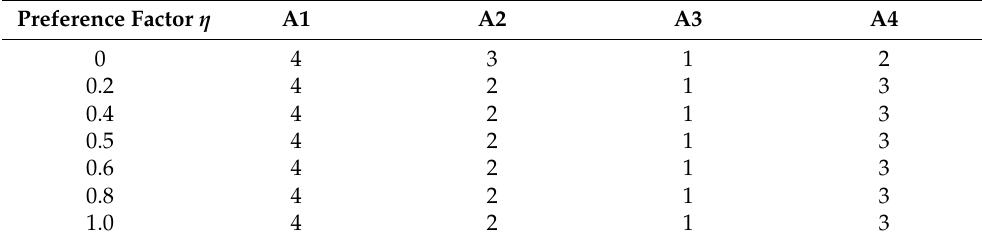
Table 8. Sorting results of selecting third-party logistics